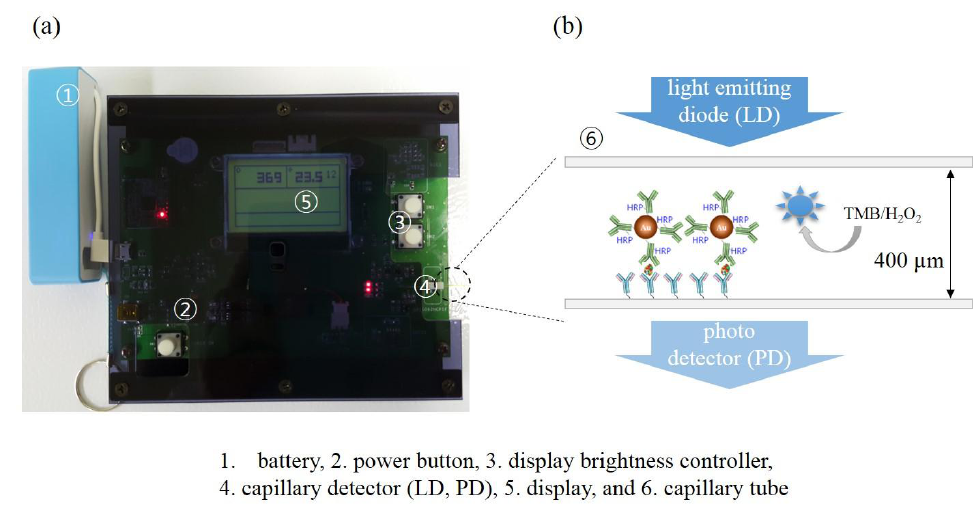
Figure 4. ( a ) The picture of the manufacture optical reader, and ( b ) schematic view illustrating the “AuNP capillary ELISA”.